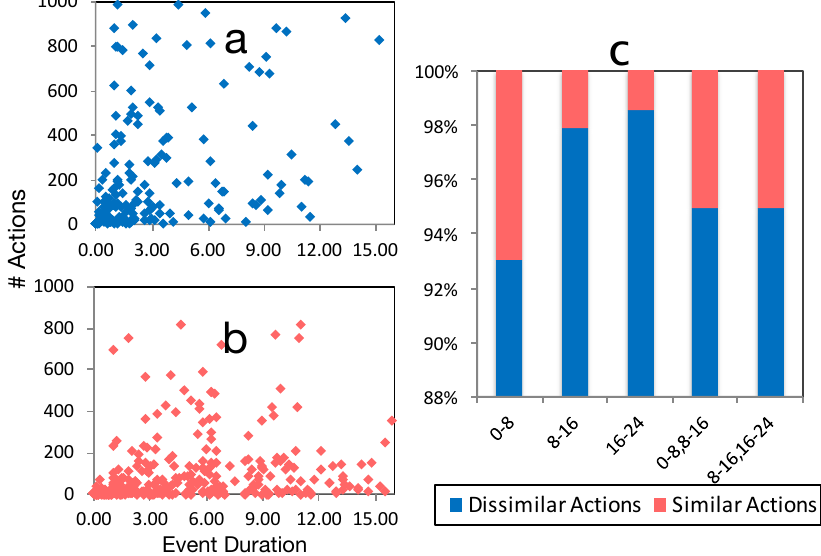
Figure 9. ( a ) distribution of similar actions (not events); ( b ) distribution of dissimilar actions; both ( a , b ) were based on event duration using ω = 3; ( c ) ratio of similar actions inside events of each cluster, distributed among different temporal